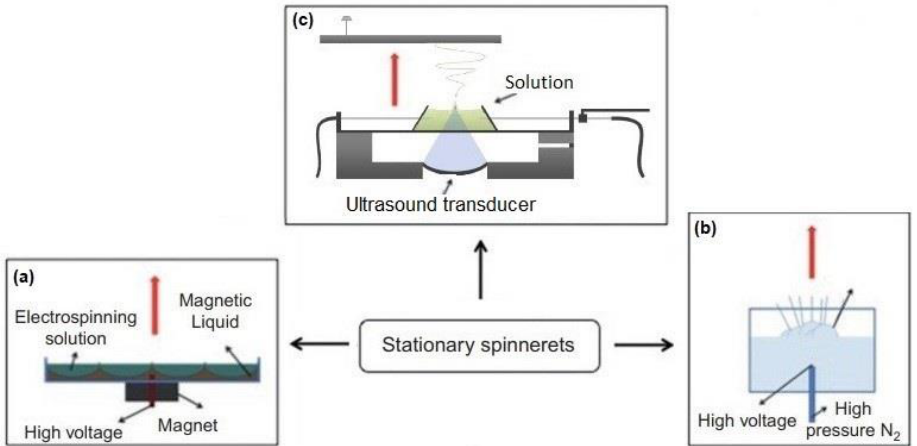
Figure 4. Schematic diagram depicting the stationary spinnerets: ( a ) ferromagnetic liquid, ( b ) bubble and ( c ) ultrasound-enhanced electrospinning, USES (electrospinning direction along the red arrow). Adapted with permission (CC BY 3.0) from [39,45] .